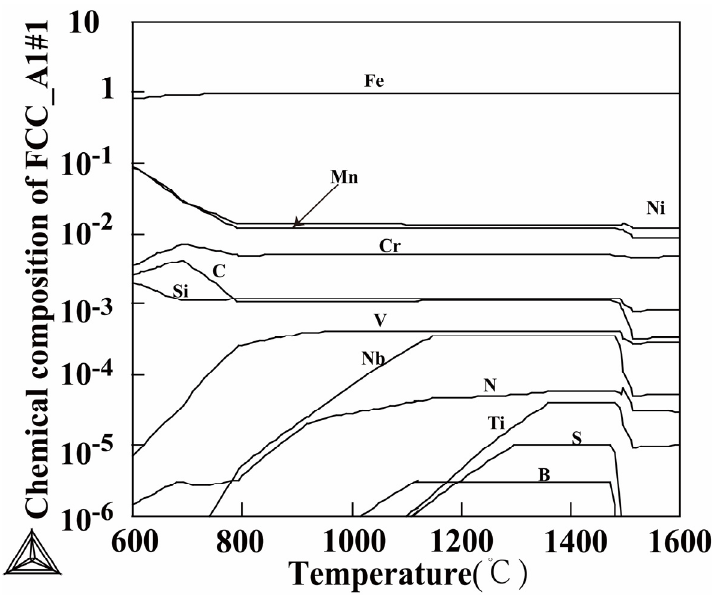
Figure 5. The composition of austenitic phase elements in the experimental steel.